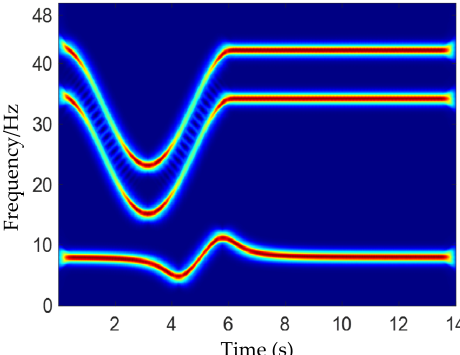
Figure 2. TF distribution of the simulated signal based on GLCT.